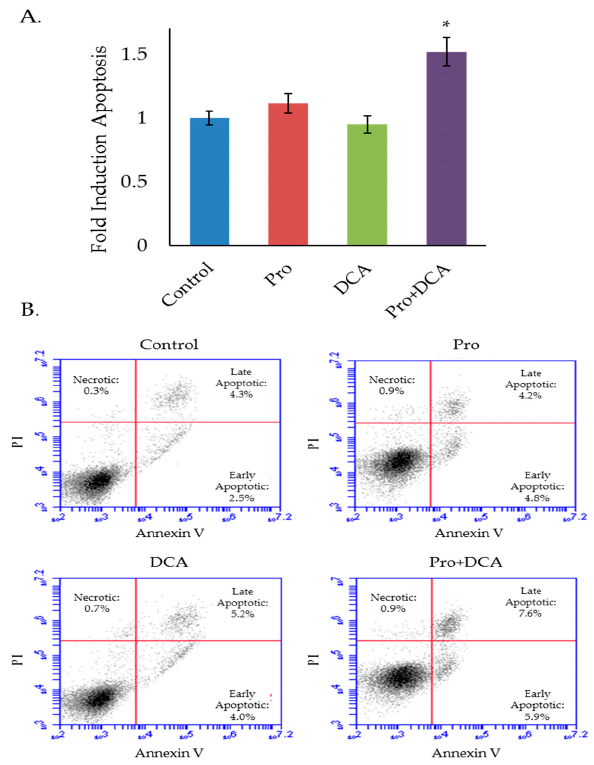
Figure 5. The combination of propranolol and DCA induces apoptosis. Results ( A ) and representative flow cytometry scatter plots ( B ) of MLM3 cells treated with propranolol (40 µ M) and/or DCA (10 mM) for 48 h and stained with annexin V and propidium iodide (PI) to assess cell death and apoptosis. Values in (A) reflect fold induction of apoptosis (indicated by positive annexin staining) relative to control. Data were pooled from two independent experiments. Each data point represents mean +/ − SEM of n = 5 independent biological replicates; p -values reflect t -test results (* p < 0.02 vs. all other treatment groups).